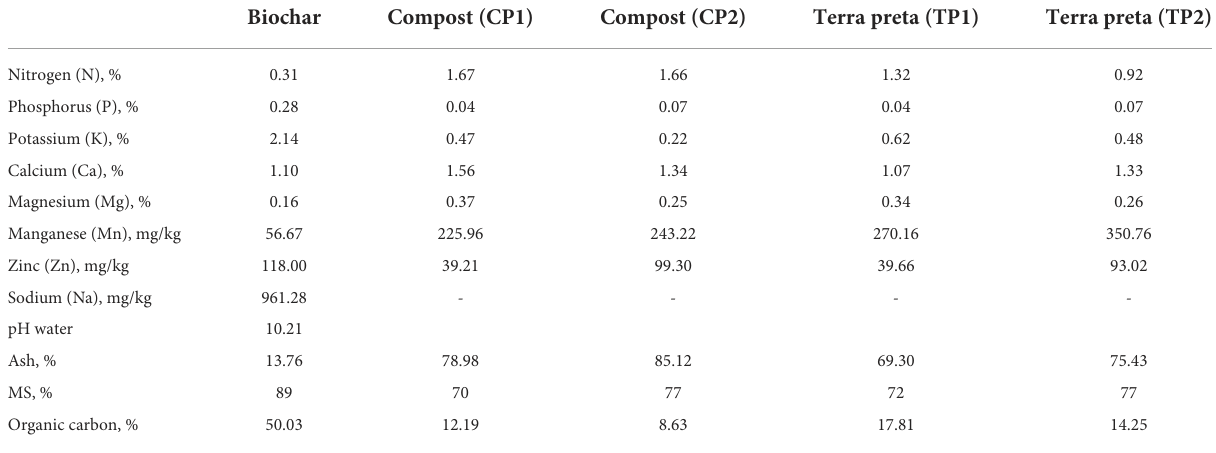
TABLE 2 Chemical composition of the different organic amendments used.